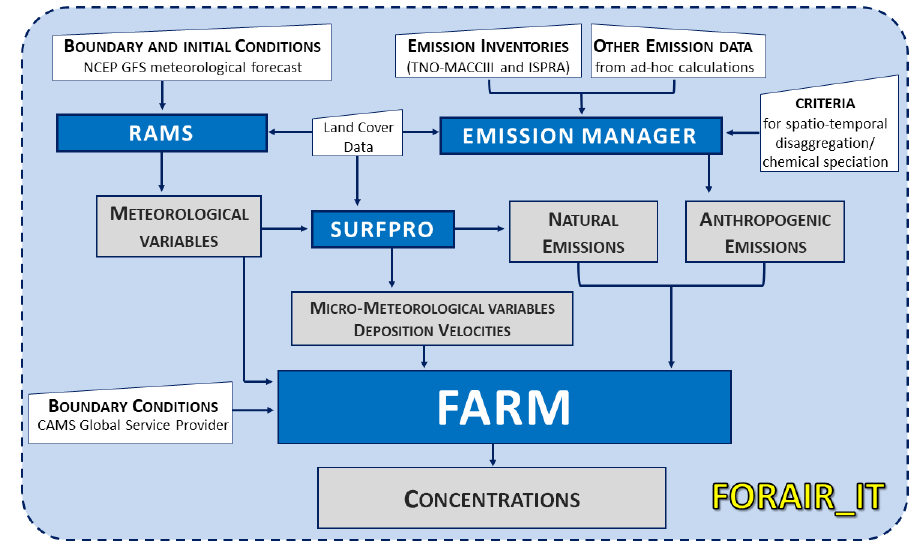
Figure 1. Flowchart scheme of the FORAIR_IT model system.